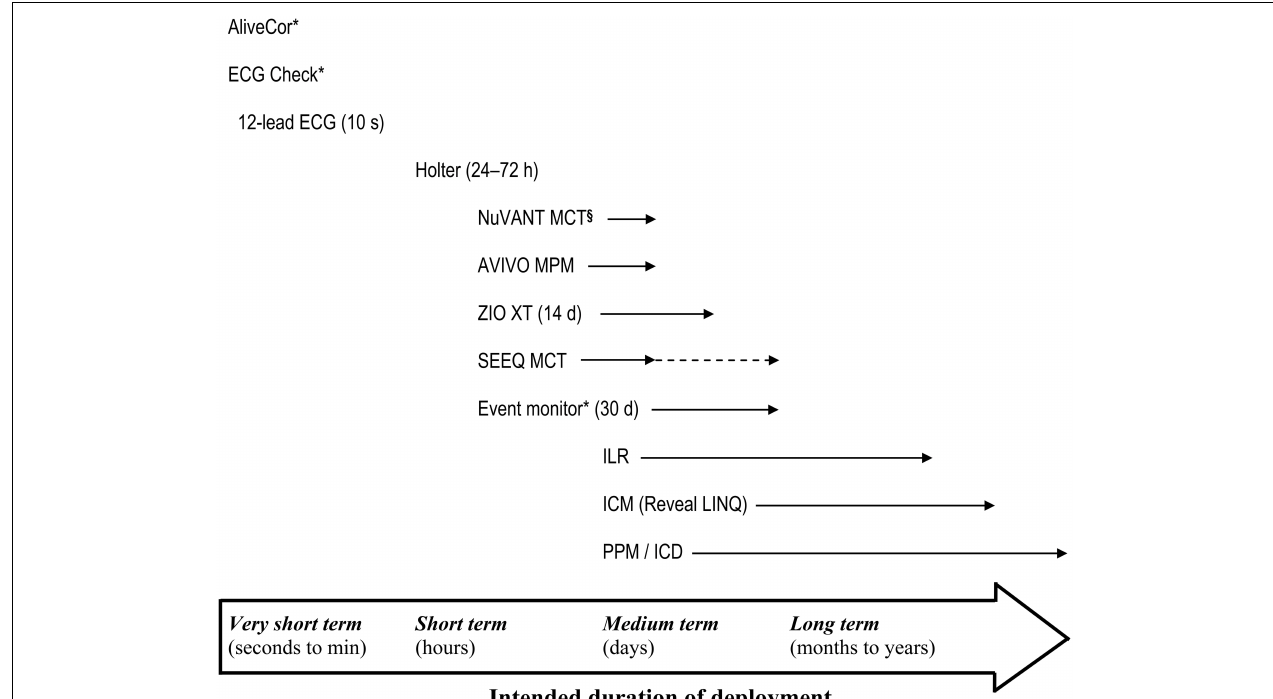
need for water resistance, ability to tolerate presence of device). Dashed line with arrow indicates serial deployment of multiple patch devices to achieve a study period of 30 days. ICD, implantable cardioverter defibrillator. ICM, injectable cardiac monitor. ILR, implantable loop recorder. PPM, pacemaker. * Manual contact and triggering required for intermittent activation or operation. § Superseded by SEEQ